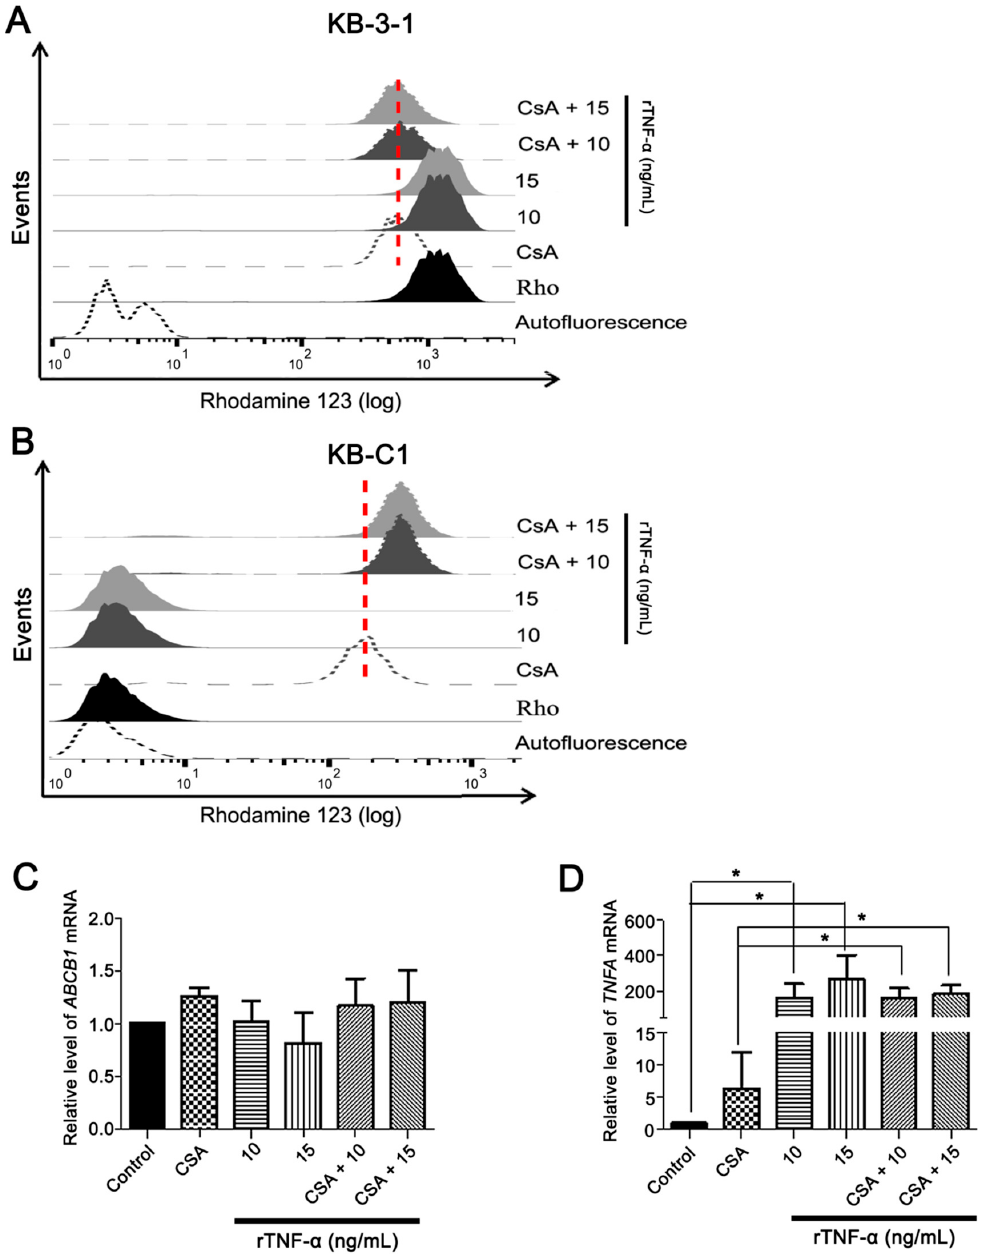
Figure 4. P-glycoprotein (Pgp) e ffl ux activity influence in ABCB1 and TNFA expression in the MDR cell line. ( A ) E ffl ux activity determined by rhodamine 123 (Rho) assay in KB-3-1 cells after 24 h of rTNF- α treatment, using flow cytometry. ( B ) Pgp e ffl ux activity determined by rhodamine 123 (Rho) assay in KB-C1 cells after 24 h of rTNF- α treatment, using flow cytometry. ( C ) ABCB1 and ( D ) TNFA mRNA levels determined by qRT-PCR after modulation of Pgp e ffl ux activity using cyclosporine A (CsA) and treatment with 10 or 15 ng / mL rTNF- α for 24 h in KB-C1 cells. ( A , B ) Empty black histogram represents cellular autofluorescence; black histogram represents Rho staining; empty gray histogram represents Rho staining after CsA incubation; dark gray and light grays histograms represent Rho staining after treatment with 10 or 15 ng / mL rTNF- α , respectively. Dark gray dashed and light gray dashed histograms represent Rho staining after treatment with 10 or 15 ng / mL rTNF- α and CsA incubation, respectively. Data are means ± SD of three independent experiments. One-way ANOVA with Dunn’s posttest were used to analyze the qRT-PCR results. * p < 0.05 indicates the statistical significance of data compared to non-treated or CsA treated